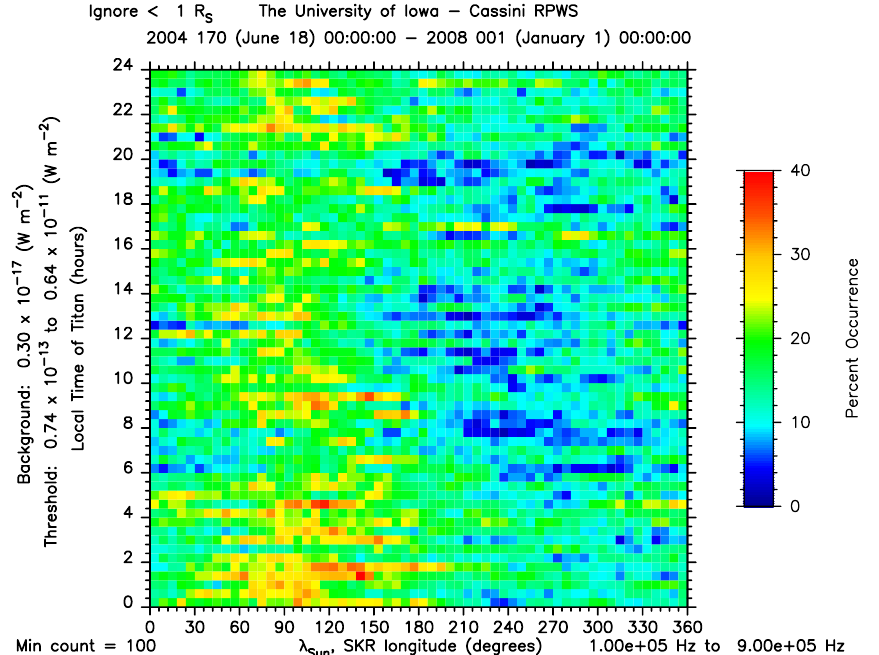
Fig. 2. Summary plot in the frequency range 100kHz <f < 900kHz, for data obtained over the period from 18 June 2004 to 1 January 2008. The local time of Titan is plotted versus SKR longitude with occurrence probability of SKR color-coded according to the color bar at right.